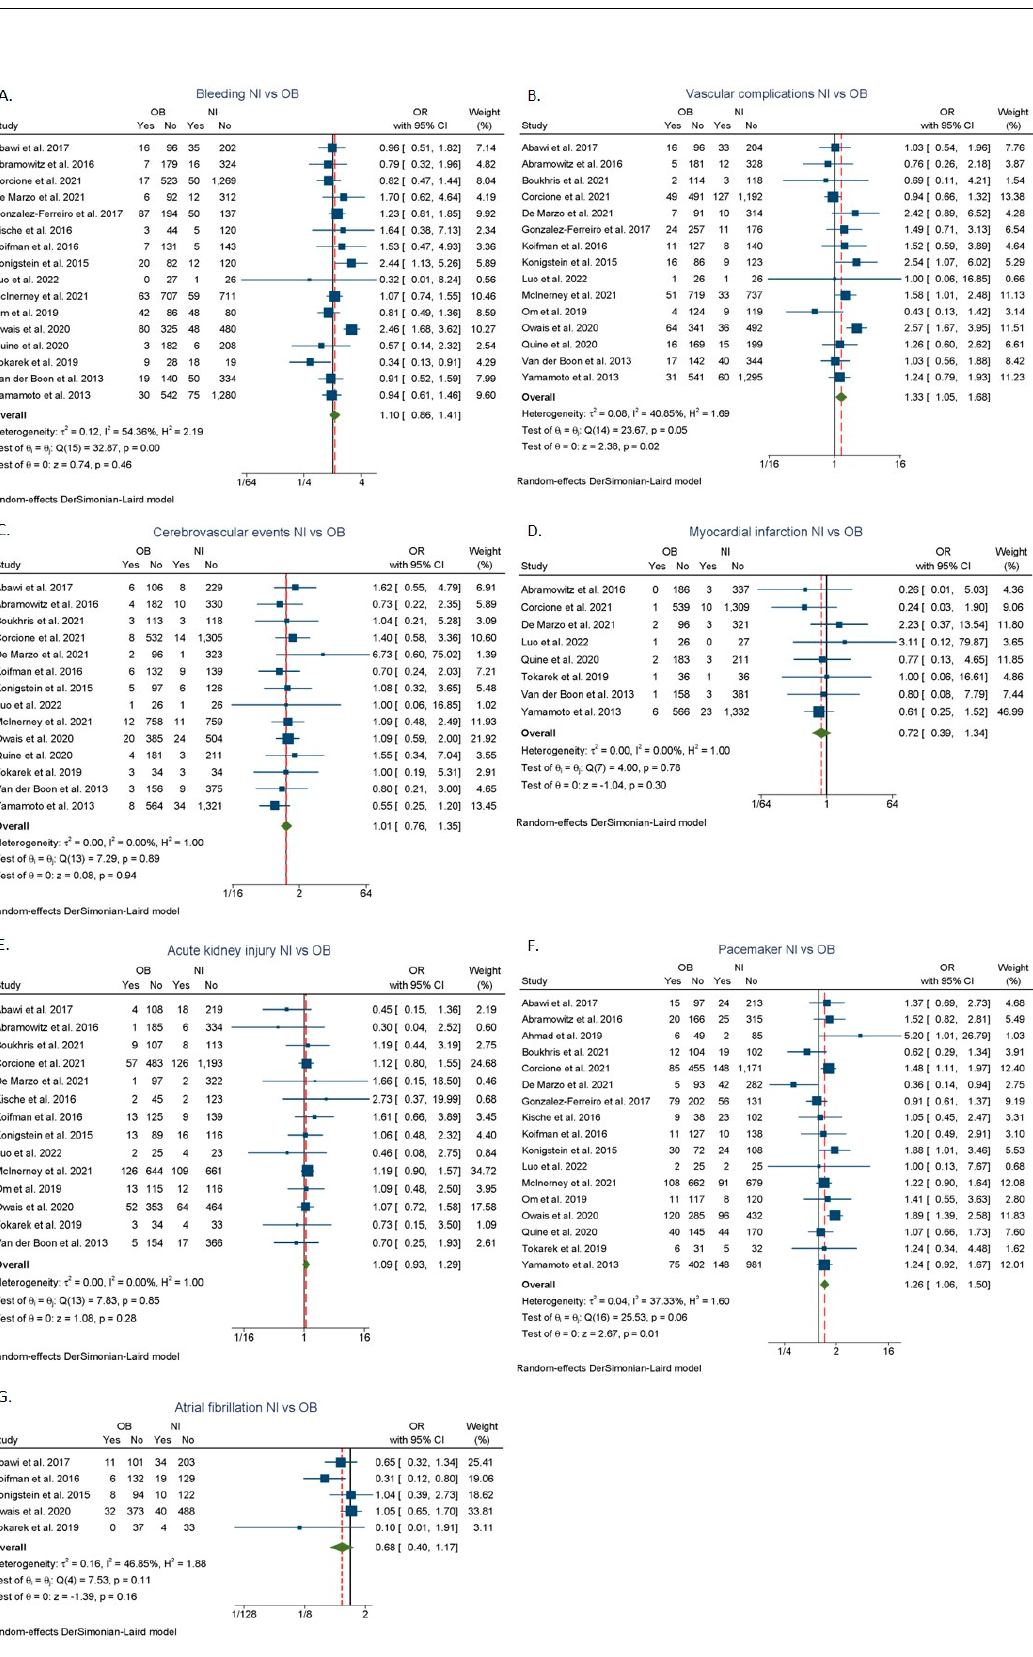
Figure 5. Complication rates after TAVR between normal BMI and obesity categories. ( A ) Major bleeding. ( B ) Major vascular complications. ( C ) Cerebrovascular events. ( D ) Myocardial infarction. ( E ) Acute kidney injury. ( F ) Permanent pacemaker insertion. ( G ) Atrial fibrillation. Nl: normal BMI; OW: overweight; OB: obesity; OR: odds ratio